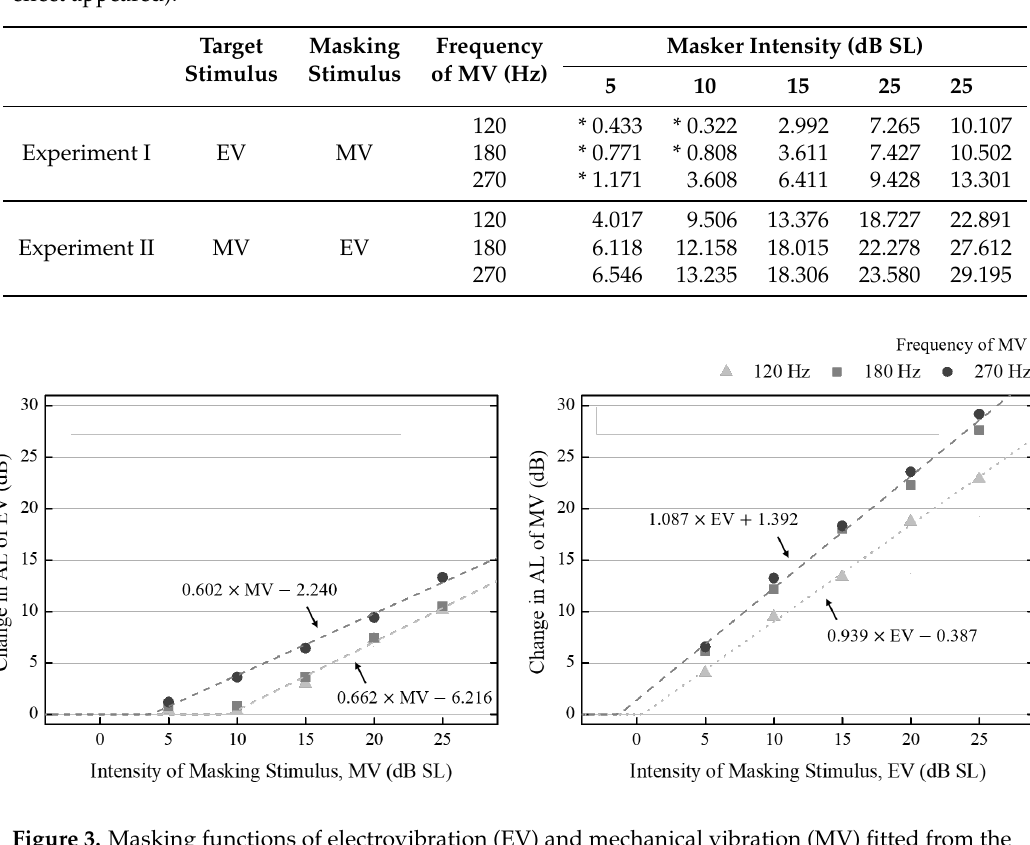
Table 2. Mean changes in the absolute threshold (AL) of electrovibration (EV) and mechanical vibration (MV) (in dB) at different frequency pairs, and under varying masker intensities. The frequency of EV was 270 Hz. The asterisks denote data that were not significantly different from 0 (i.e., no masking effect appeared).